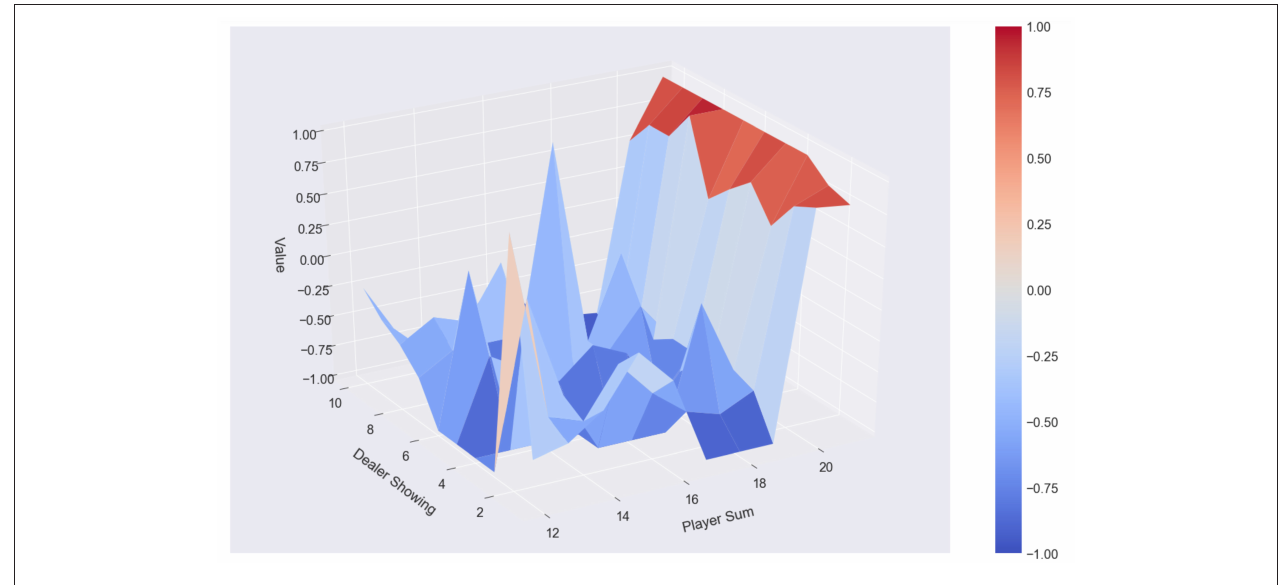
FIGURE 5 | Classical Monte Carlo: 500 episodes, policy α , no usable ace.